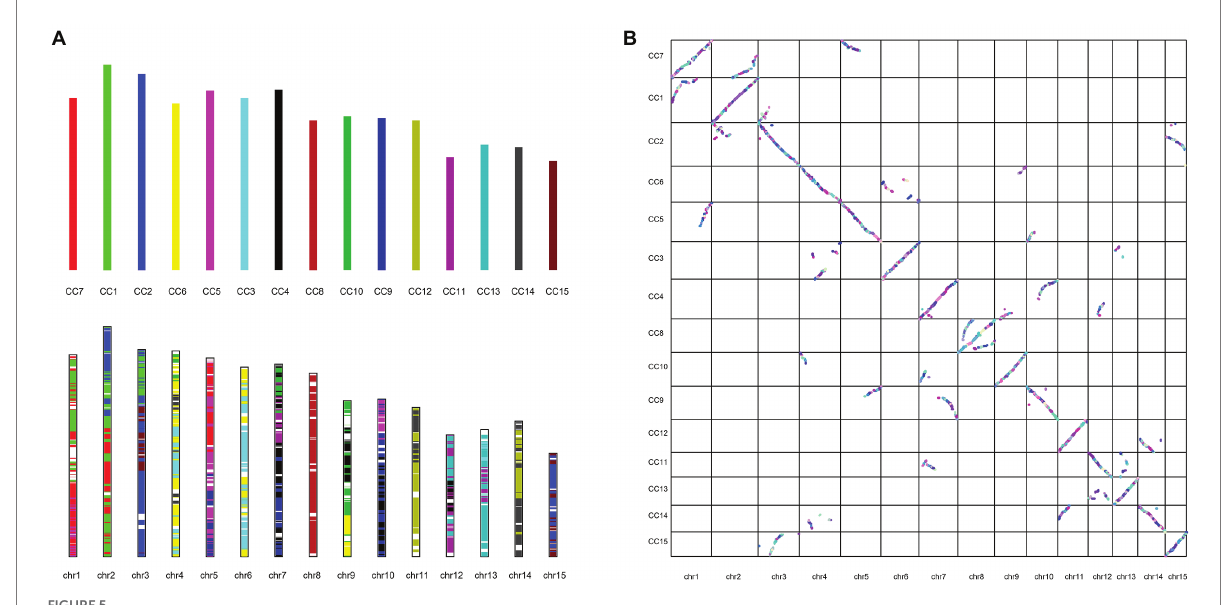
FIGURE 5 Collinearity analysis between DuyunMaojian and Shuchazao (A) . Evolutionary patterns of the chromosome-scale assembly of DuyunMaojian and Shuchazao. chr1-chr15 represent the 15 pseudo-chromosomes of DuyunMaojian. CC1-CC15 represent the 15 pseudo-chromosomes of Shuchazao. (B) . Comparison of chromosome-scale assembly of DuyunMaojian tea plant genome and